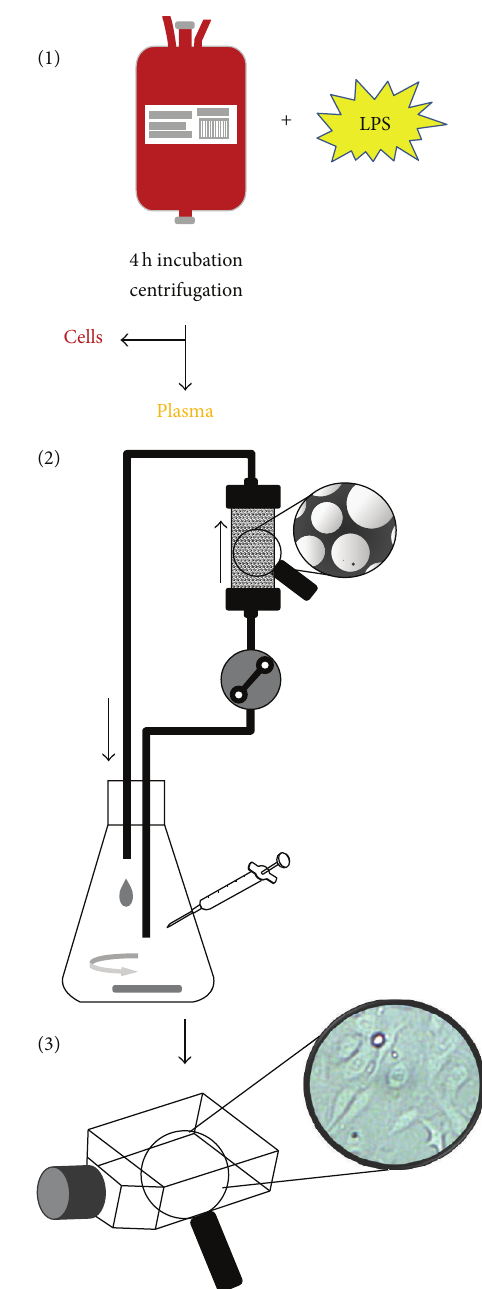
Figure 1: Schematic procedure of the experiments. The experiments were conducted in three parts: ( 1 ) blood stimulation and centrifu- gation, ( 2 ) adsorption experiments by a dynamic model, and ( 3 ) cell culture model with